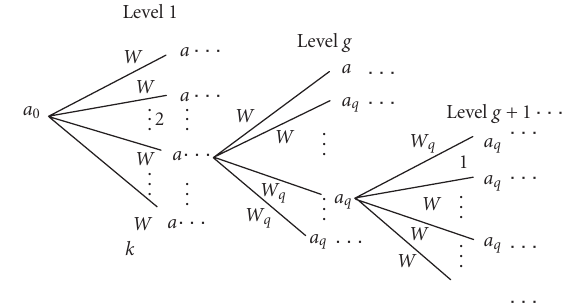
Figure 8: Fuzzy signature structure, showing top and two arbitrary levels g , g + 1.